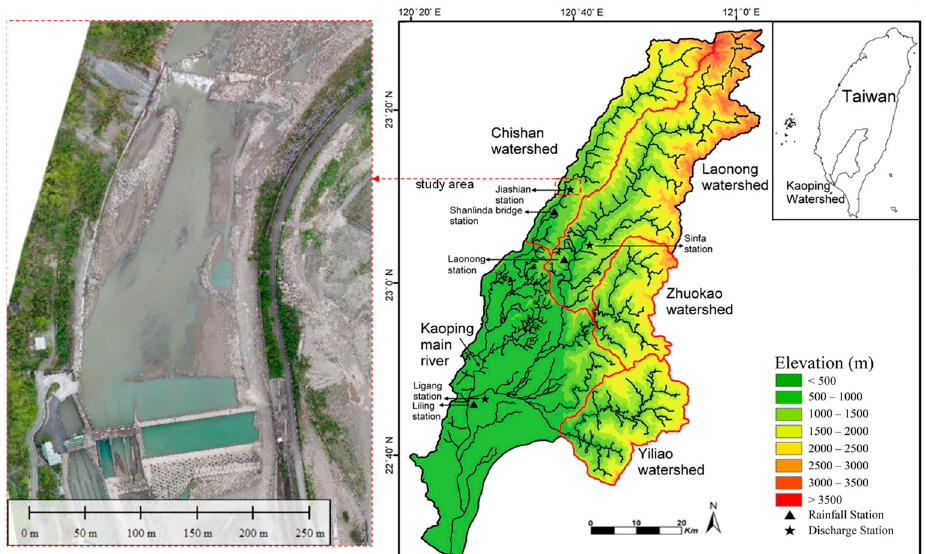
Figure 2. Location map of Kaoping River catchment, modified from [24] . The orthophoto of the study area was taken on 10 April 2017.